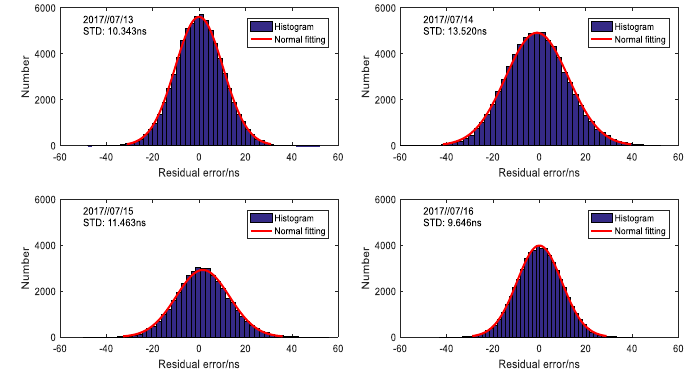
Figure 4. Character of observation noise in propagation delay.